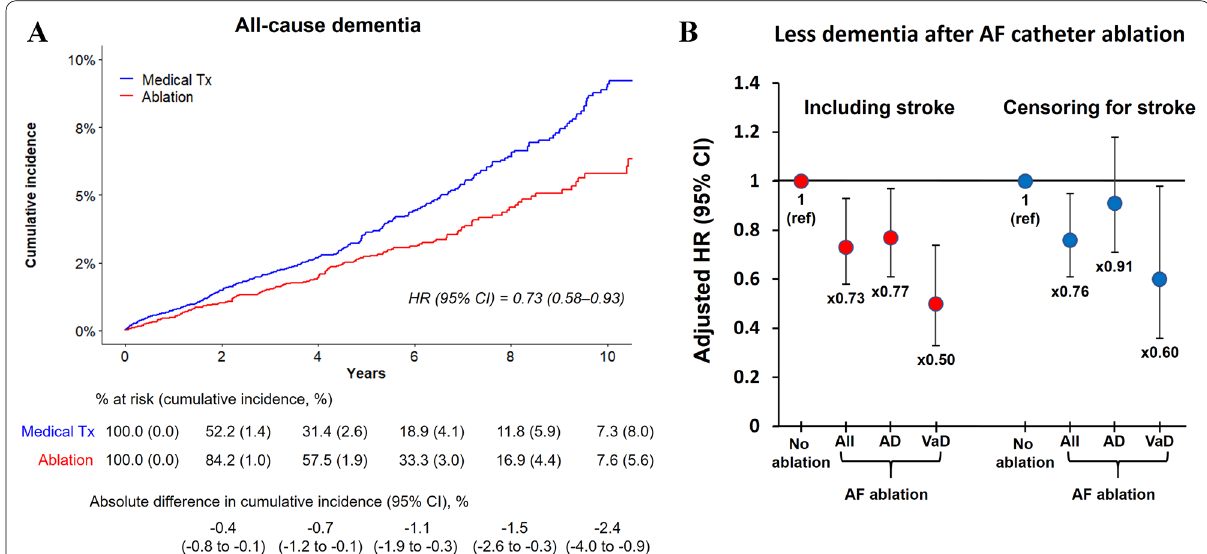
Fig. 4 A Cumulative incidence curves of overall dementia in propensity‑matched patients undergoing ablation or medical therapy and B risk of dementia in propensity score‑matched patients undergoing ablation or medical therapy. Modified from Kim et al. [47]. Alzheimer’s disease, AF atrial fibrillation, CI confidence interval, HR hazard ratio, Tx treatment, VaD vascular